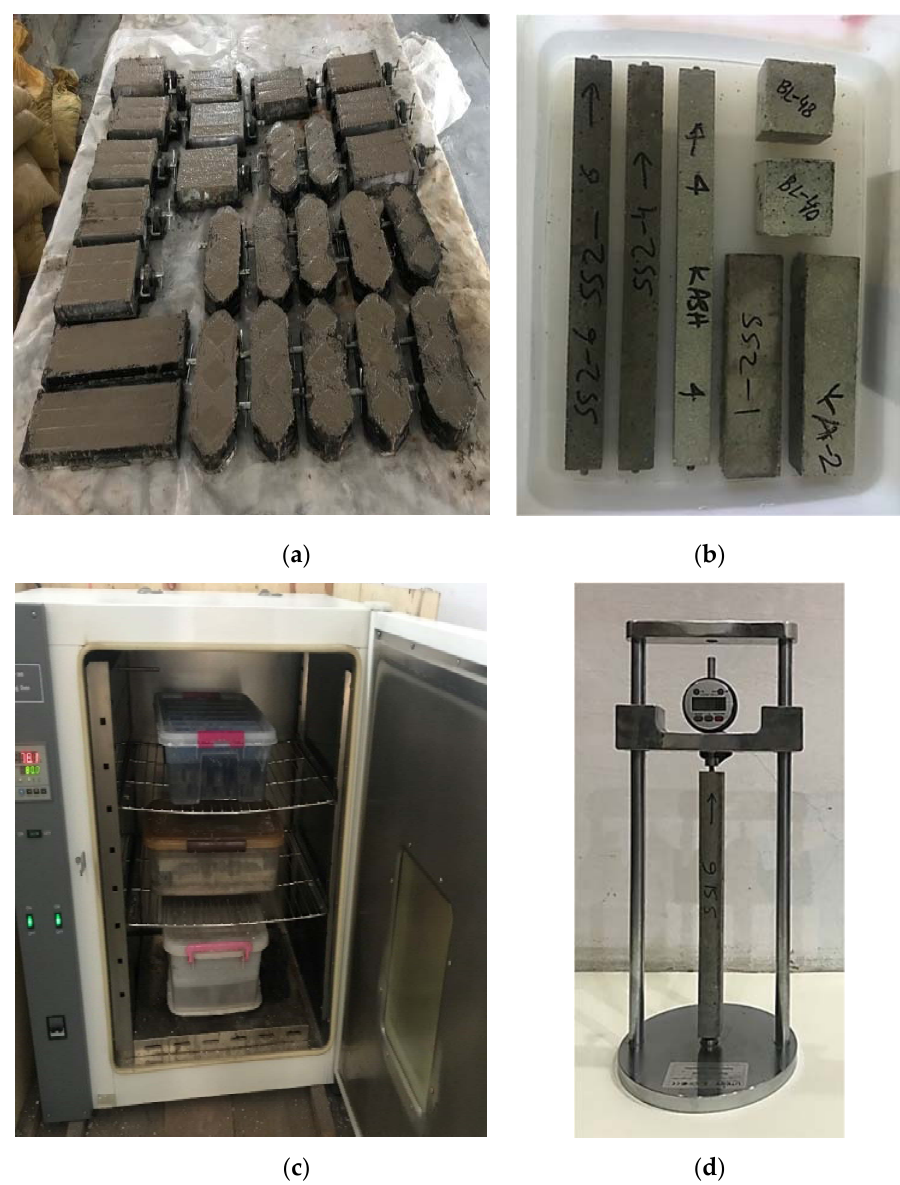
Figure 2. Preparation and testing of specimens. ( a ) Preparation of various specimens; ( b ) Specimens placed in solution; ( c ) Specimens placed in oven at 80 °C; ( d ) Digital length comparator.